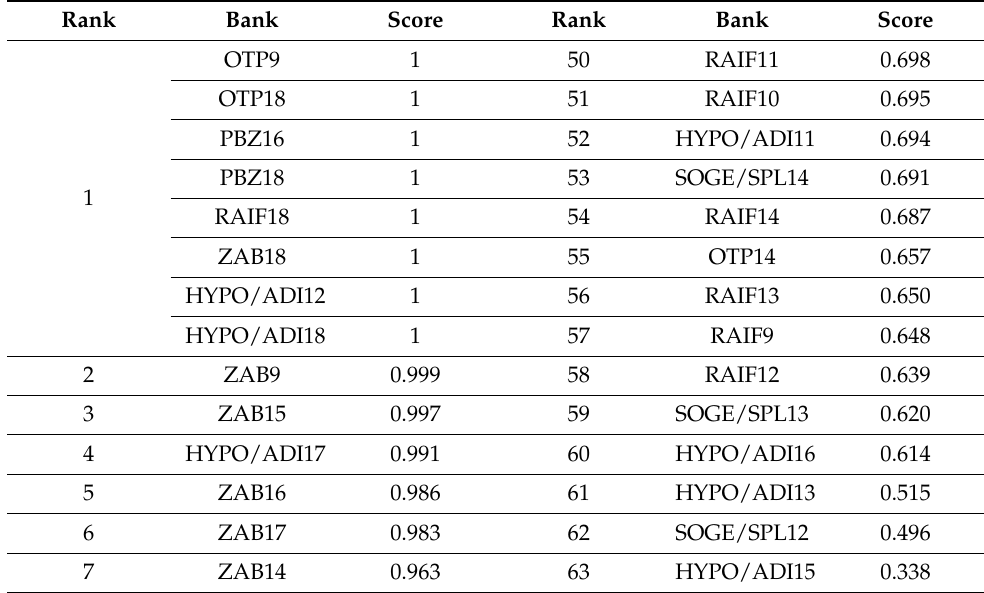
Table 4. CK indices and rankings of fuzzy efficiency scores, top and bottom